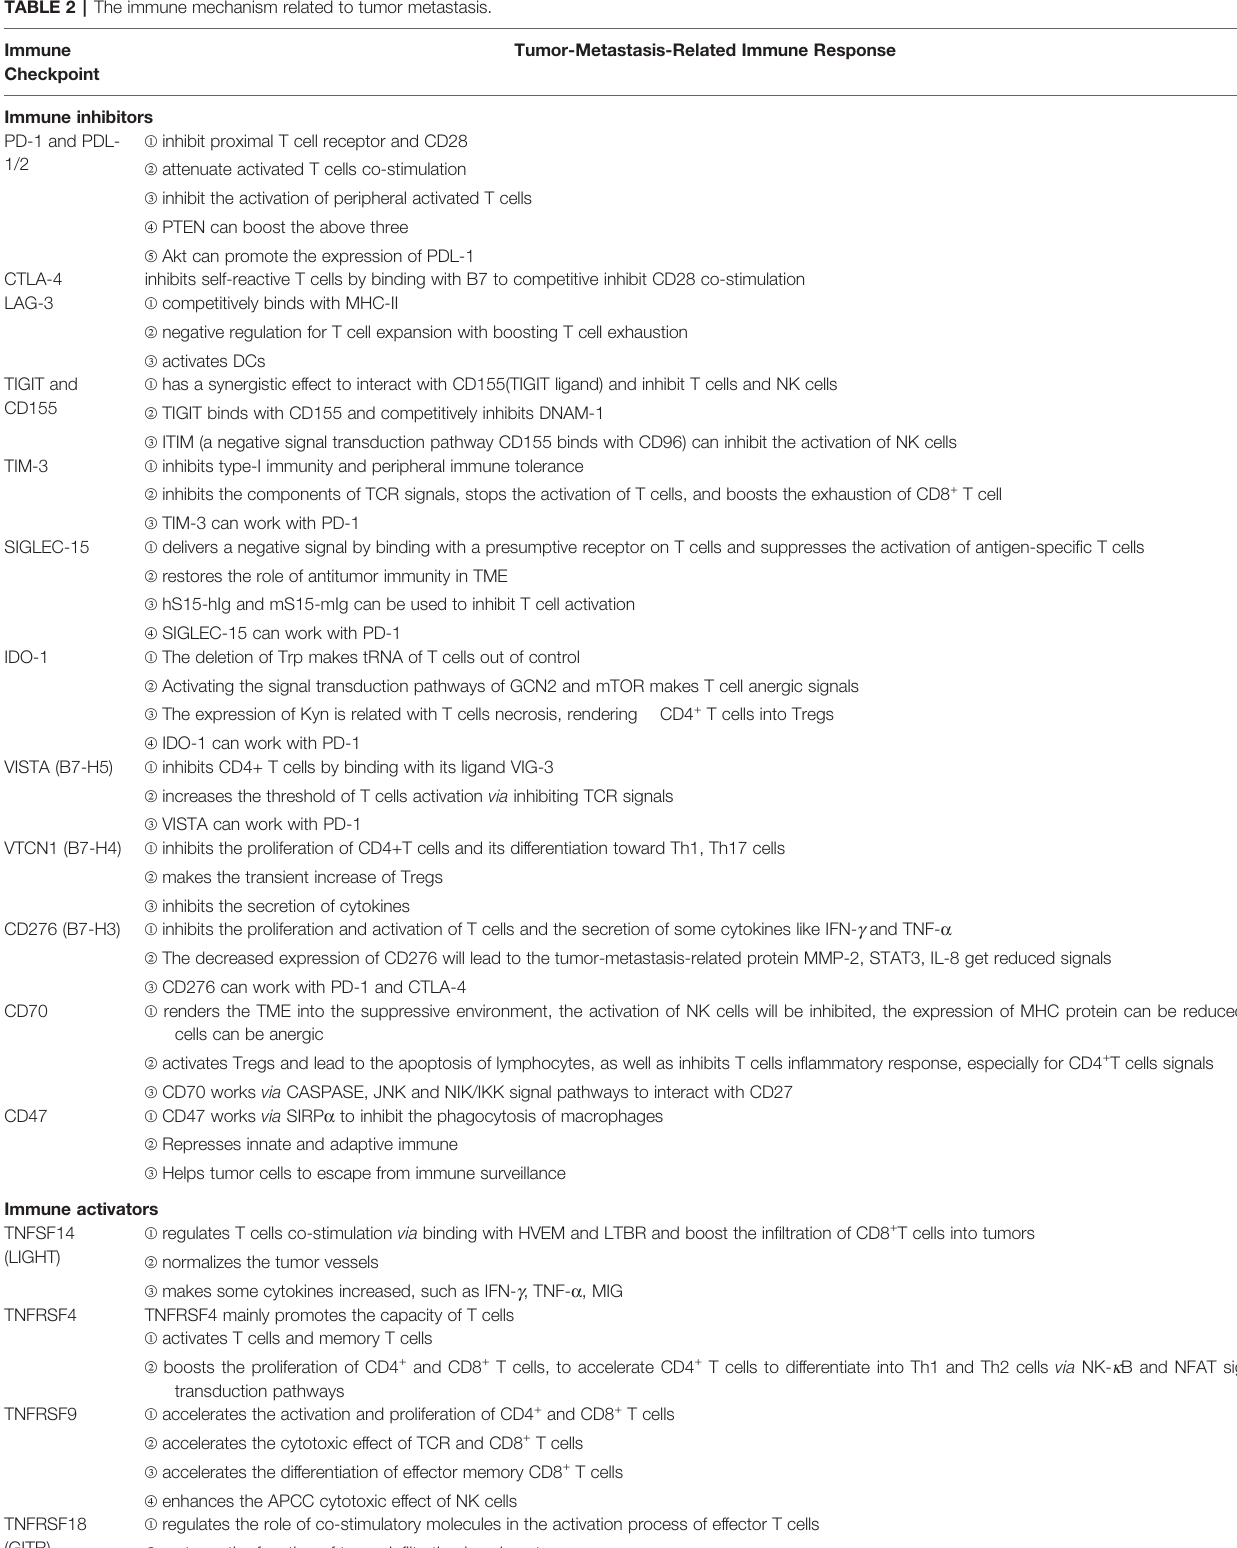
TABLE 2 | The immune mechanism related to tumor metastasis. Immune